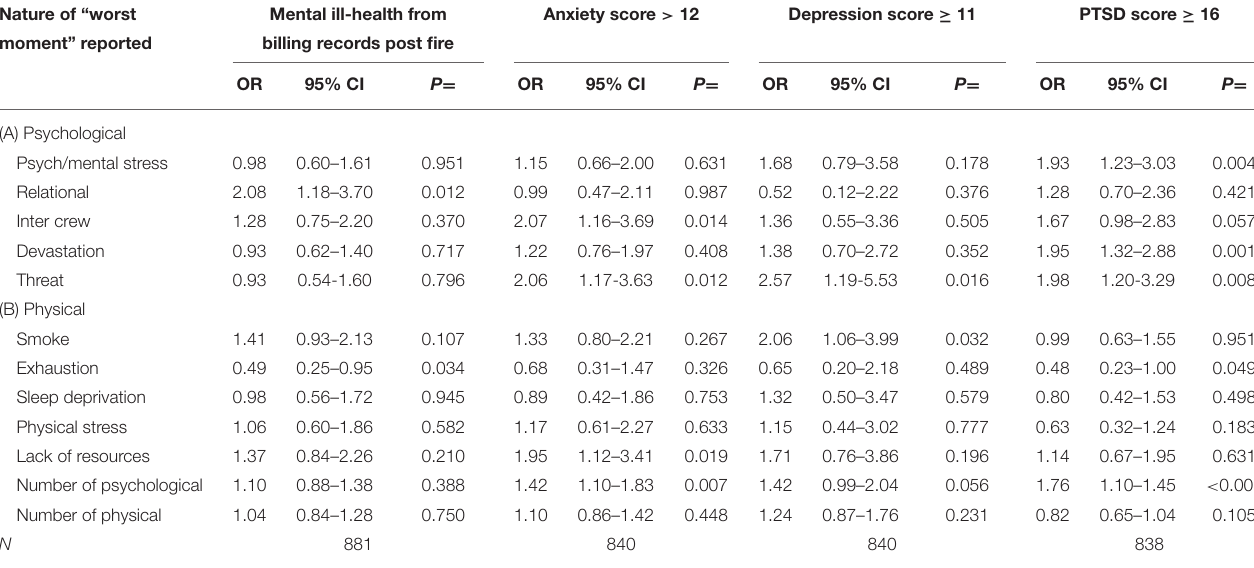
TABLE 7 | Relation of mental ill health 2 years or more post fire to “worst moment.” Nature of “worst Mental ill-health from Anxiety score > 12 Depression score ≥ 11 PTSD score ≥ 16 moment”